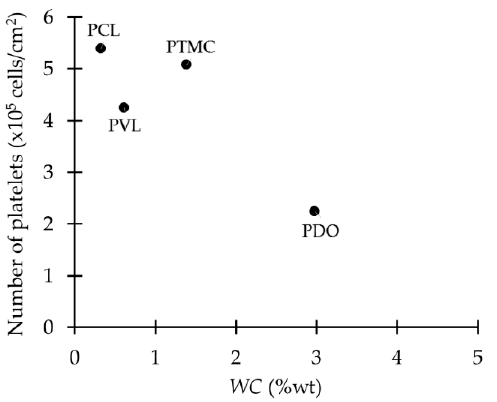
Figure 14. Relation of intermediate water content and platelet adhesion in aliphatic carbonyl polymers. Data extracted from [62].